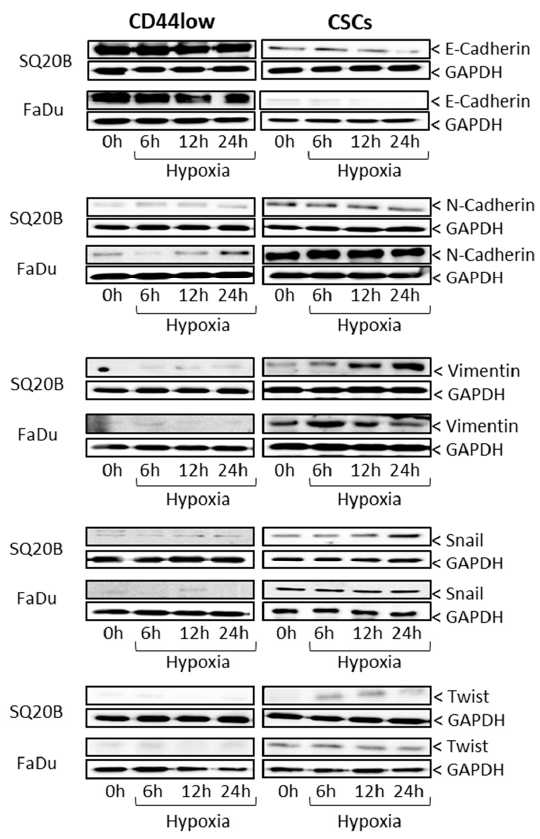
Figure 2. Impact of acute hypoxia on the epithelial-to-mesenchymal transition (EMT) phenotypes of CSCs and non-CSCs. Representative Western blots of epithelial markers (E-cadherin), mesenchymal markers (N-cadherin, vimentin) and stemness markers (Snail, Twist) in the four HNSCC subpopulations under normoxia (0 h) and after 6, 12 and 24 h of acute hypoxia ( n = 3, Supplementary Figure S1). Under normoxia and hypoxia, both CSC subpopulations exhibited a mesenchymal phenotype (i.e., elevated expression of N-cadherin and vimentin and low expression of E-cadherin)